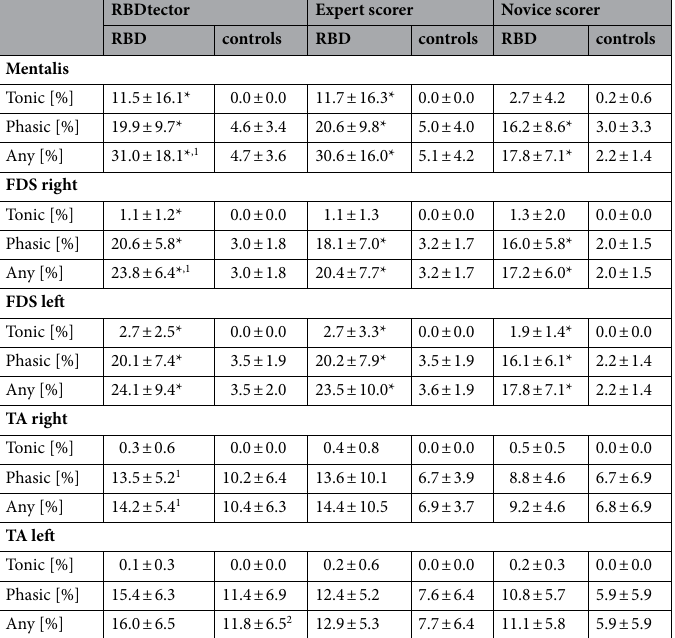
Table 2. RSWA indices of RBD-positive patients and controls evaluated by human scorers and the RBDtector. RBD rapid eye movement sleep behaviour disorder, FDS flexor digitorum superficialis muscle, TA tibialis anterior muscle. Statistics: *significant difference between RBD and controls, 1 significant difference between RBDtector and novice scorer, no significant difference found between RBDtector and expert scorer and expert and novice scorer. Significance was accepted at p < 0.05 uncorrected, Student’s t tests and Mann–Whitney U tests were applied as